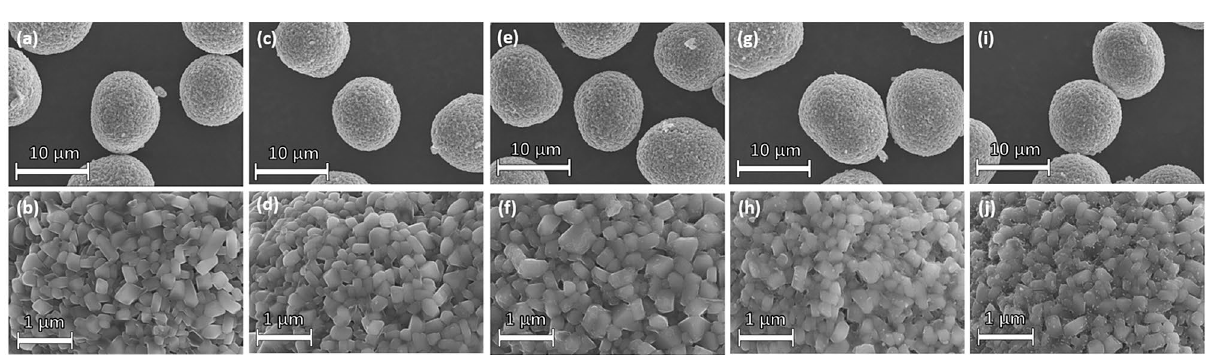
Figure 2. XPS spectra of Ni, Co, Mn, C and P for the pristine and LiP-0.1 sample.